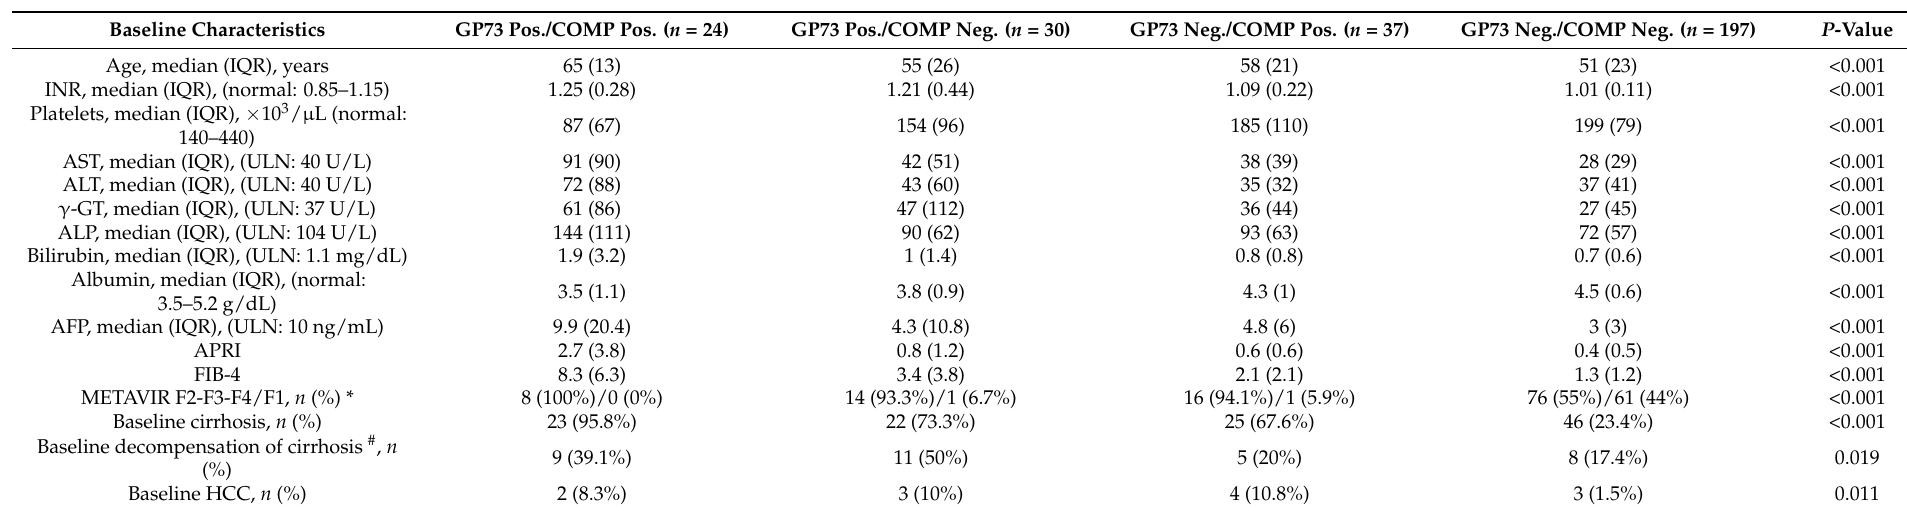
Table 2. Baseline demographic, clinical, and laboratory characteristics of patients according to COMP and GP73